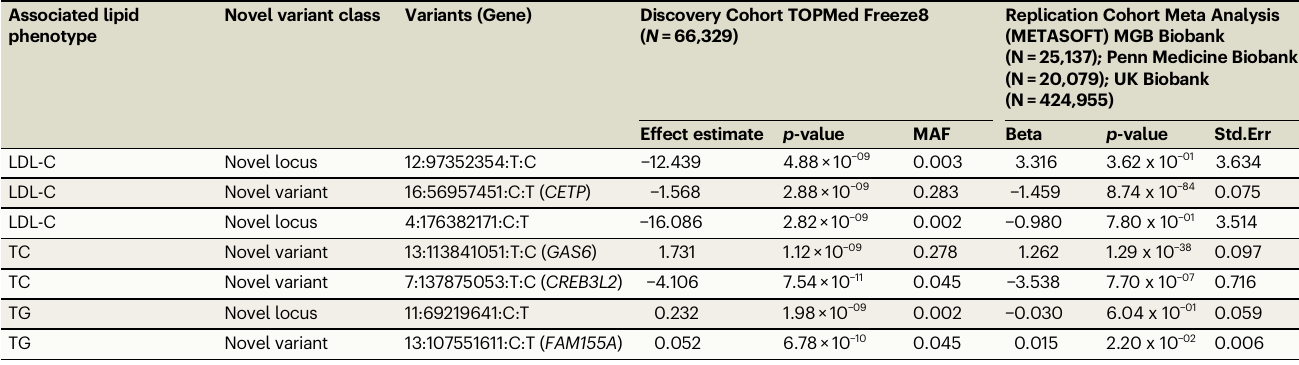
Table 1 | Putative novel variants identi fi ed in TOPMed and evidence for replication Associated lipid Novel variant class Variants phenotype